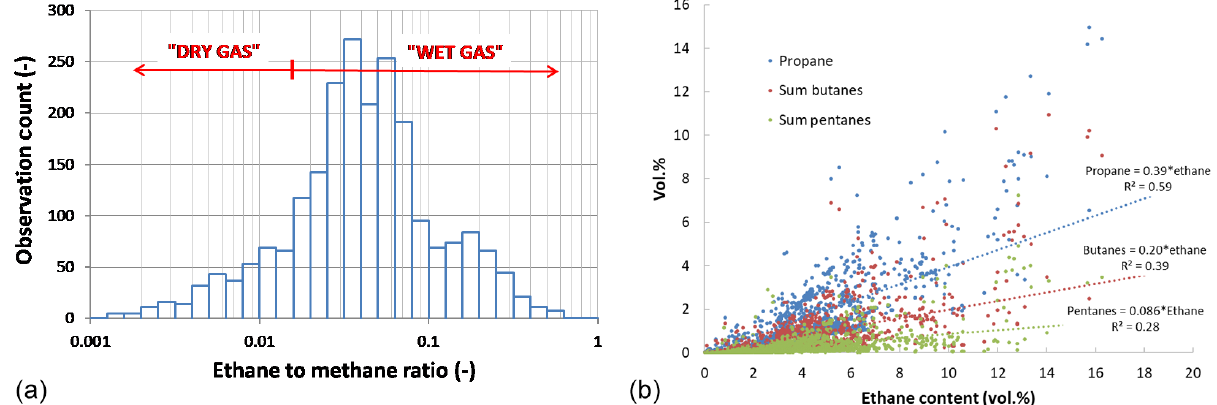
Figure 2. (a) Histogram of the ethane to methane ratio (C 2 / C 1 ) as found in Europe in conventionally produced natural gas (left) and (b) frac- tion of higher alkanes as function of the ethane content (right) based on the raw gas composition database compiled by Doornenbal